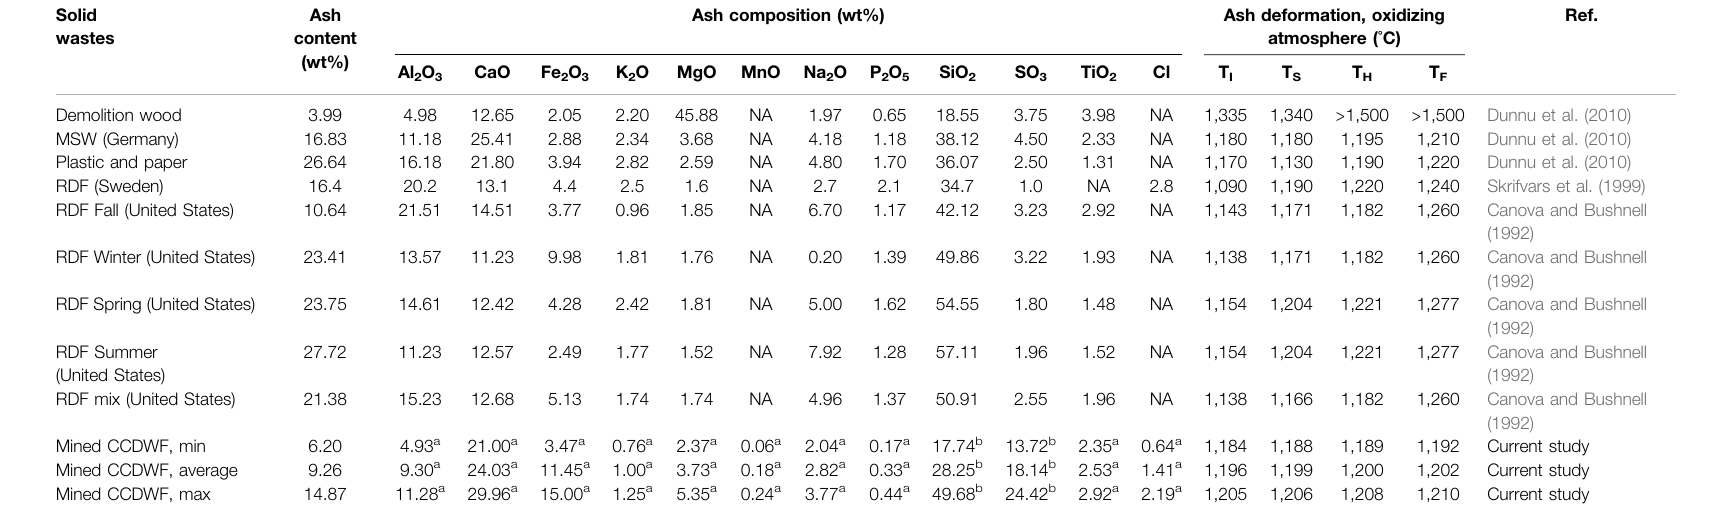
TABLE 8 | Ash composition and fusibility of selected solid wastes. Solid wastes